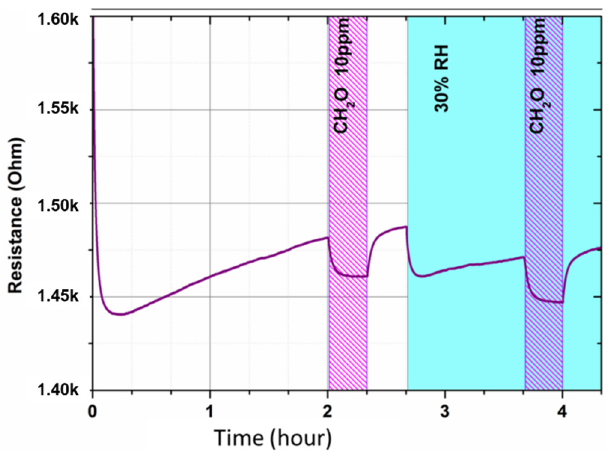
Figure 12. Static test: resistance measurement versus time under various atmospheres. Injection of 10 ppm of formaldehyde under dry air and then under humid air (30%RH).